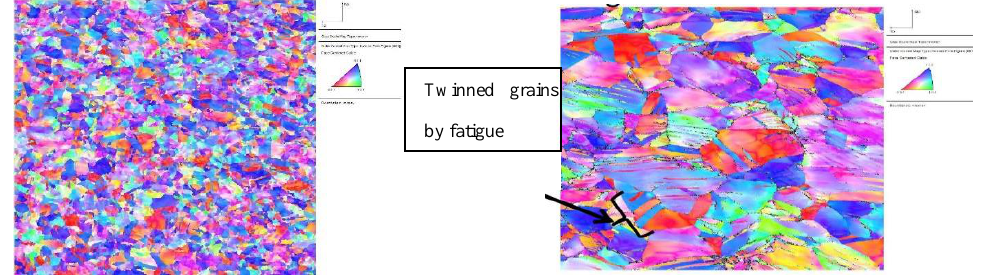
Figure 7. Electron backscatter di ff raction (EBSD) grain map of the PHILOS Plate ( left ). Crystallographic characterization of plate microstructure inverse pole figure ( right ).